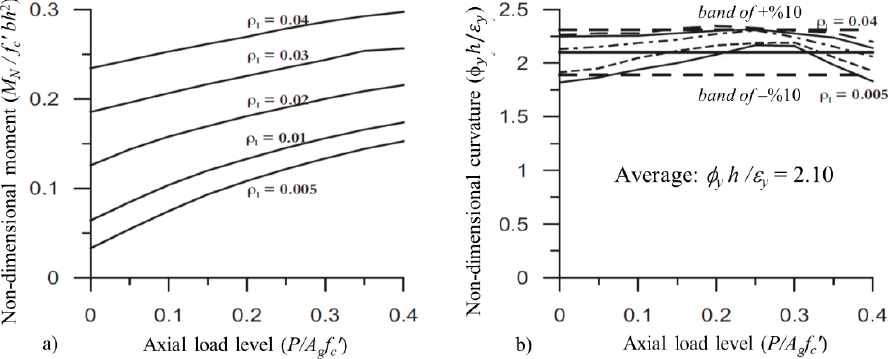
Figure 2. In non-dimensional form ( a ) moment capacities, and ( b ) equivalent yield curvatures